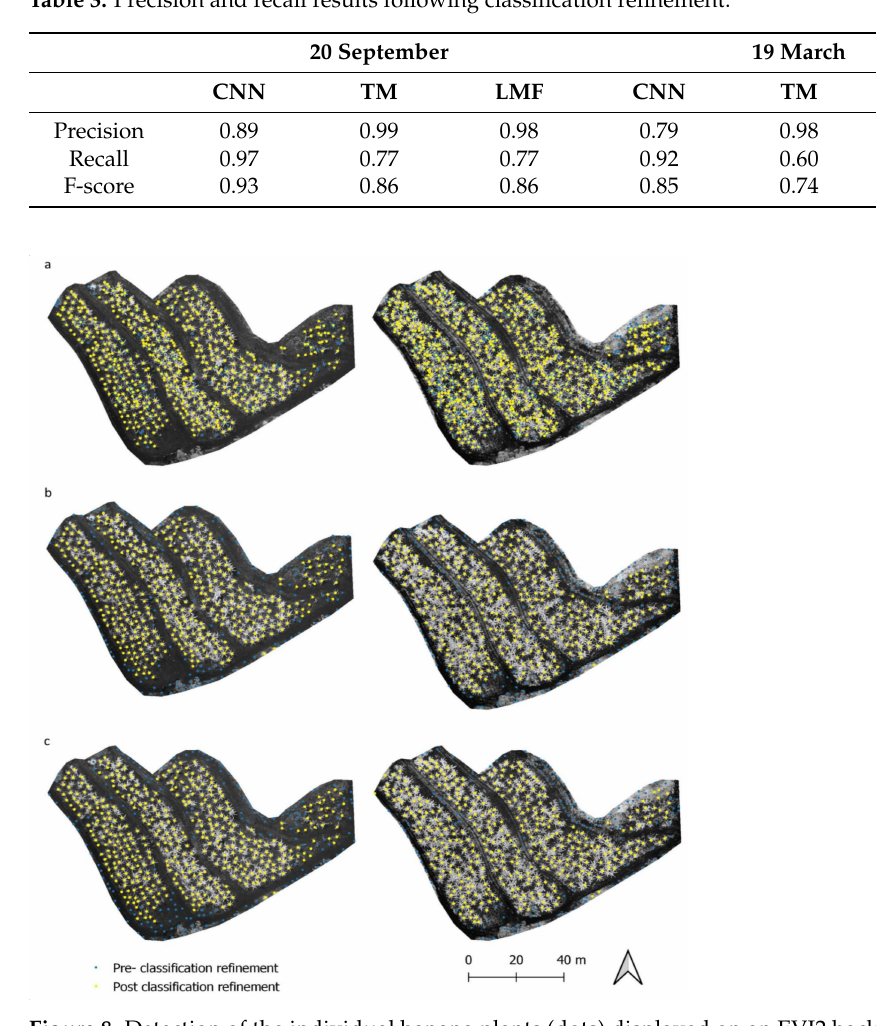
Figure 8. Detection of the individual banana plants (dots) displayed on an EVI2 background layer based on rows. ( a ) convolutional neural network (CNN) ( b ), template matching (TM), and ( c ) local maxima filtering (LMF) for the UAV image data collected on 20 September and 19